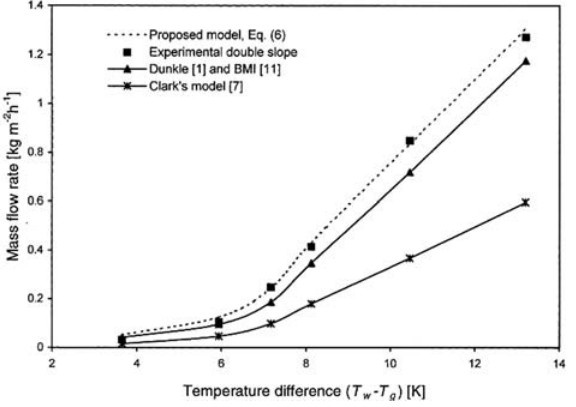
Figure 4. Distillate yield production for different mathematical models (Reprinted from [13], with permission from Elsevier, 2019).